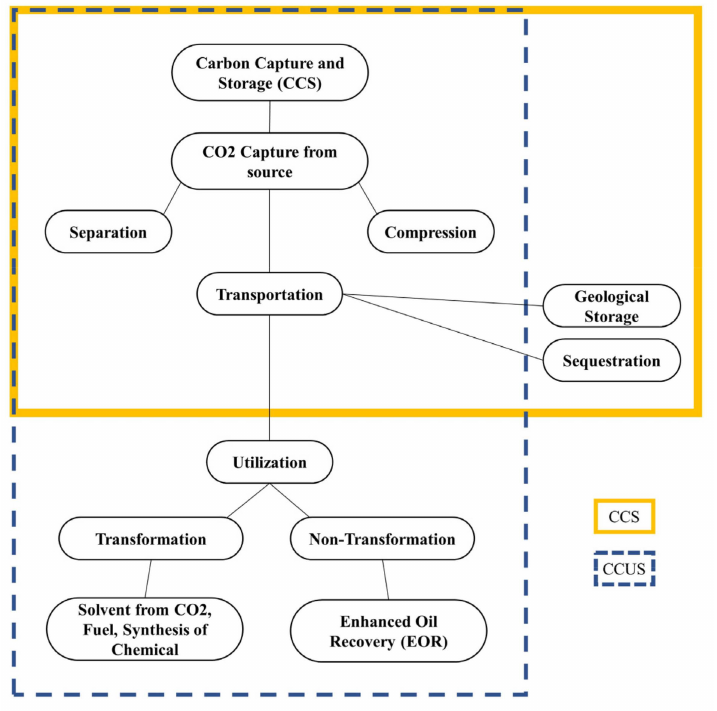
Figure 1. Difference between the CCS and CCUS